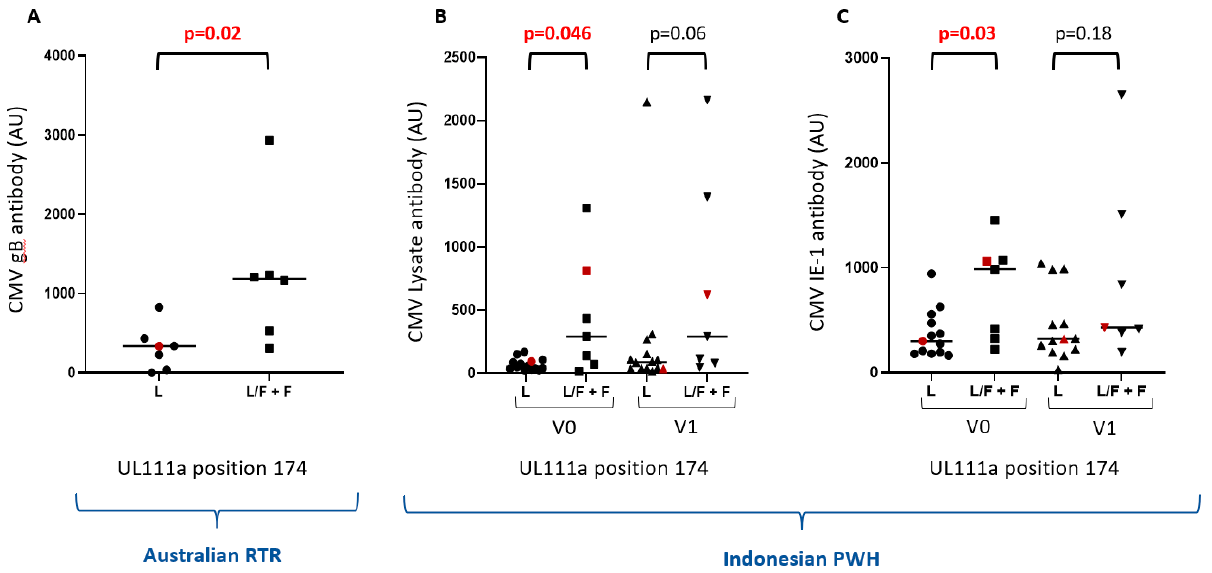
Figure 4. RTR and PWH carrying HCMV with the L174F variant have higher levels of HCMV-reactive antibodies: ( A ) comparison of HCMV gB-reactive antibodies in Australian RTR carrying HCMV with L at position 174 and those carrying either L/F or F; ( B ) comparison of HCMV lysate-reactive antibodies in Indonesian PWH carrying HCMV with L at position 174 and those carrying either L/F or F; ( C ) comparison of HCMV IE-1-reactive antibodies in Indonesian PWH carrying HCMV with L at position 174 and those carrying either L/F or F. V0 = baseline (0 months on ART), V1 = 1 month on ART. The red dots represent individuals also carrying L174W variant.